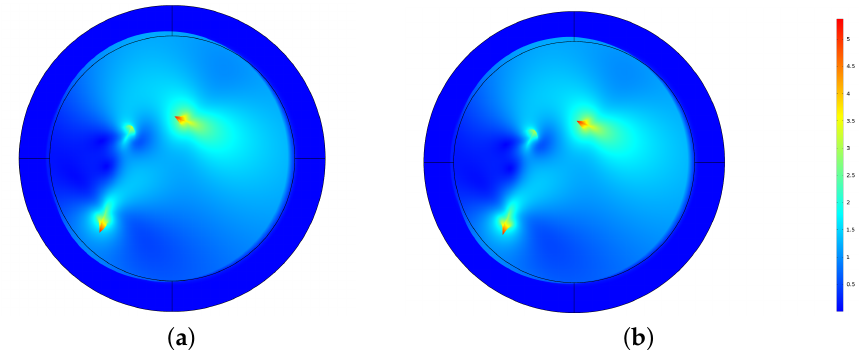
Figure 7. The waveform plots of the scattered field from three point sources, where ( a ) is the true field and ( b ) is the reconstructed field.